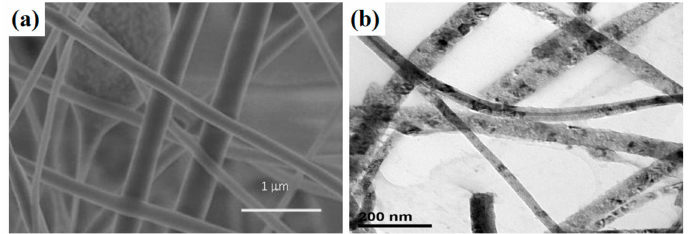
Figure 14. ( a ) SEM image and ( b ) TEM image of the TiO 2 -ZrO 2 oxide system (created based on [254] with permission from Elsevier